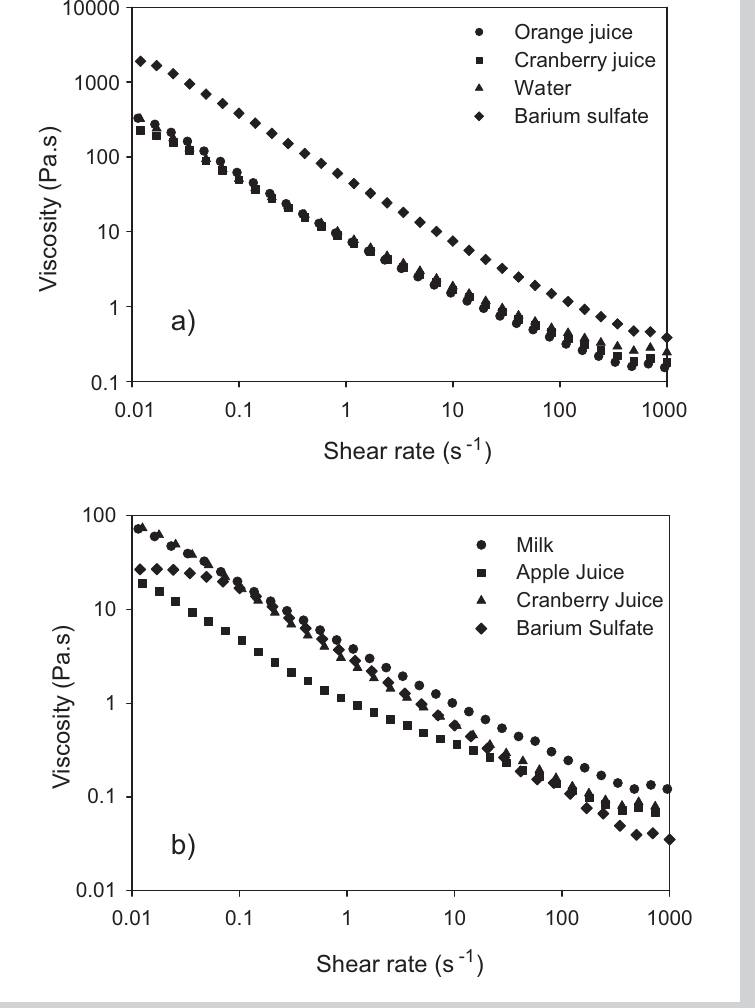
Figure 1: a) (above)Viscosity curves of samples with honey consis- tency. b) Viscosity curves of sam- ples with nectar